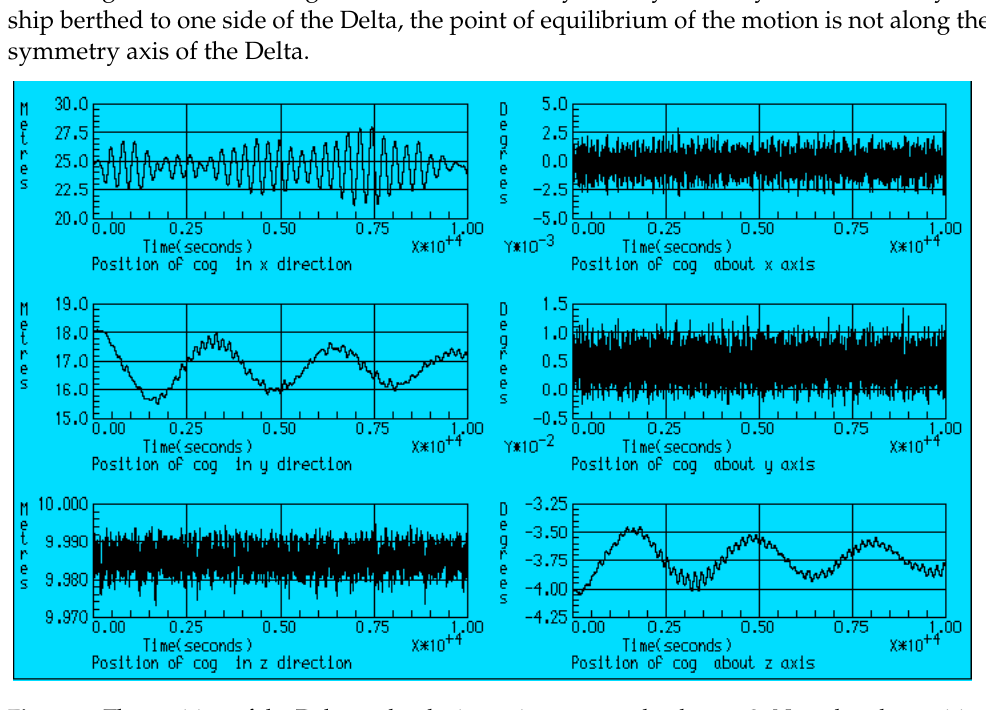
Figure 7. The position of the Delta under the incoming waves—load case c2. Note that the position of the Delta in the horizontal degrees of freedom is dominated by the slow ‐ varying and constant drift load. It is characterized by slow oscillations of large amplitude about a point of equilibrium accompanied by the low amplitude, fast wave frequency oscillation. The wave frequency position of the berthed ship along the 10,000 ‐ s simulations of the c2 and s2 load cases, are presented in Figures 8 and 9, respectively. The surge and sway motion are relative to the motions of the delta and the heave and rotational motions are absolute. However, in such conditions, the heave and rotational motions of the Delta are minimal and, therefore, negligible. The frequency position of the ship in all load cases are presented in Appendix A.